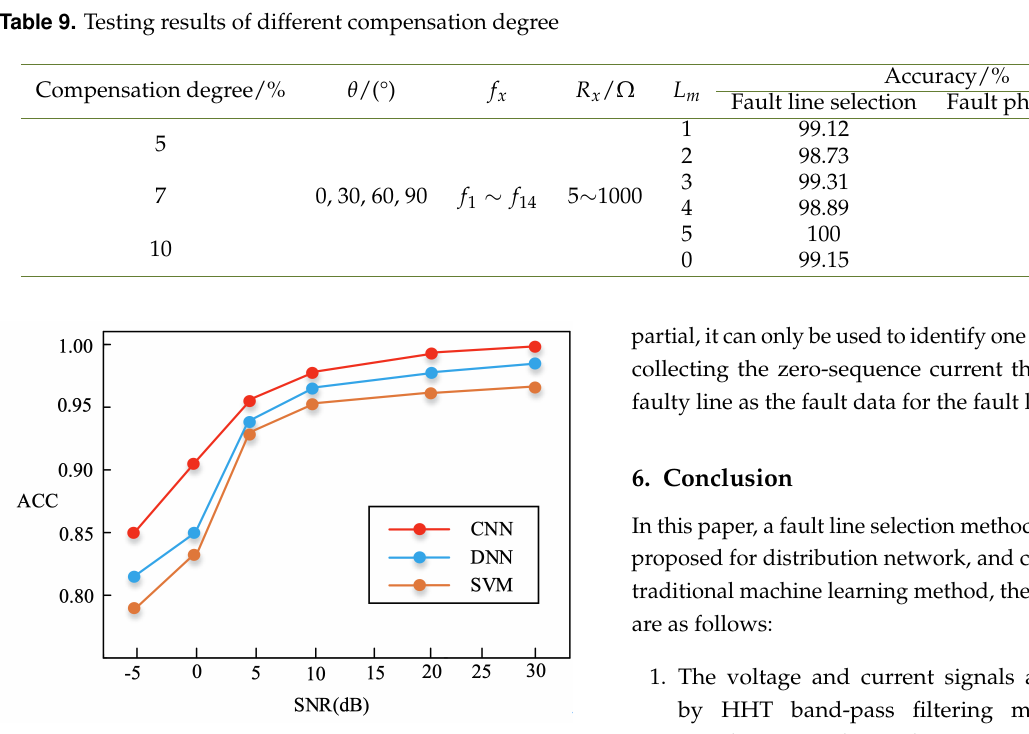
Fig. 12. The accuracy and training time of CNN and DBN